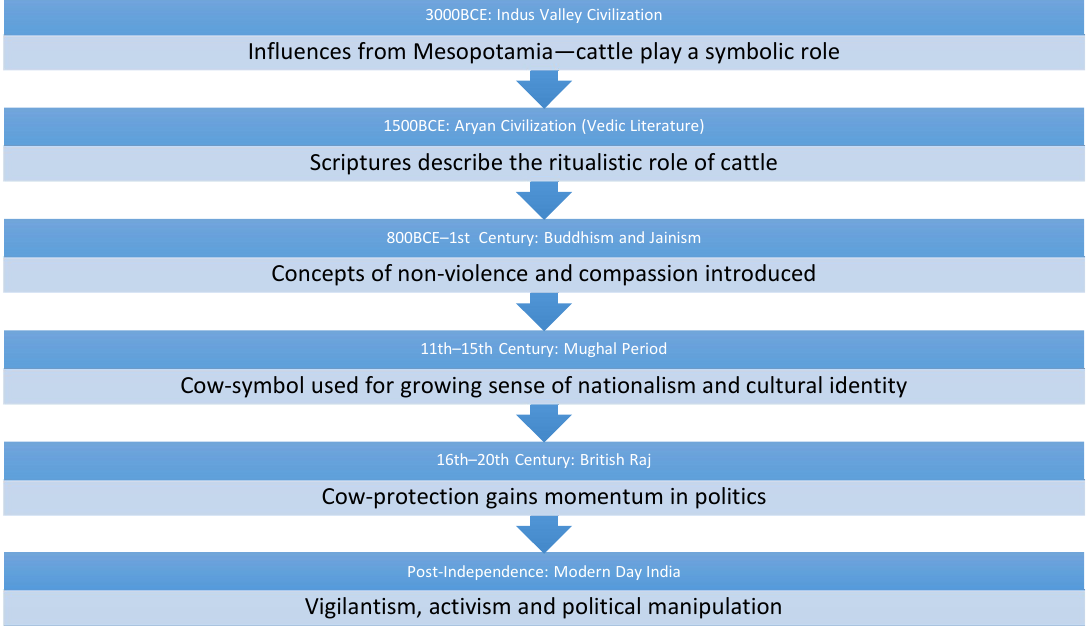
Figure 1. Chronology of Indian historical events surrounding cow-symbolism.